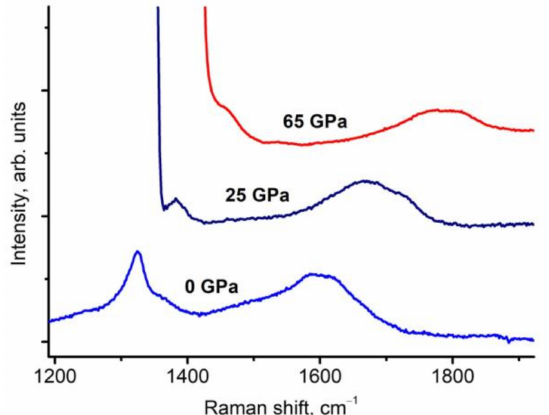
Figure 4. Transformation of the Raman spectra of the 2–5 nm nanodiamonds under pressure up to 65 GPa exited with 405 nm. The spectra show a part of the line from the stressed tip of the diamond anvil with a high content of 13